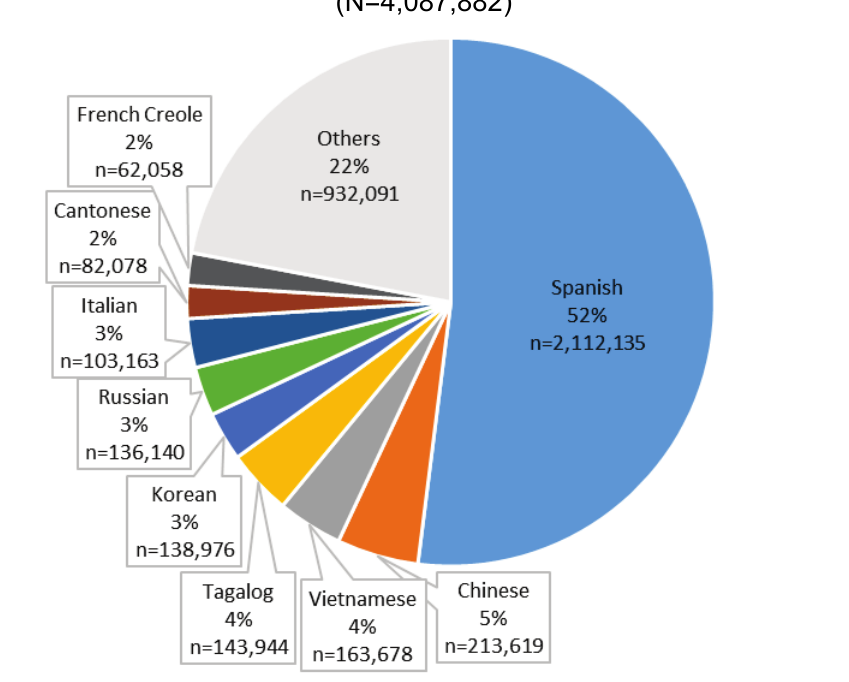
Non-English languages most commonly